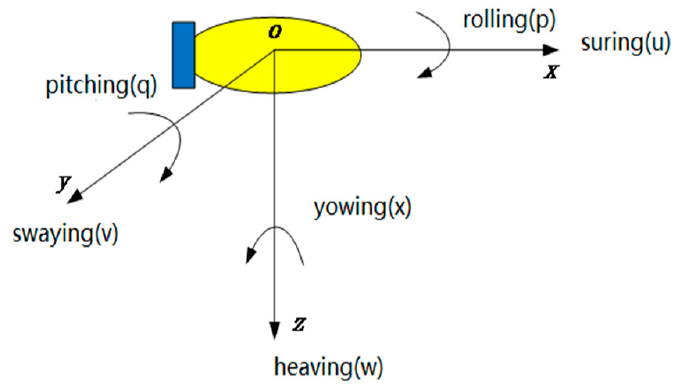
Figure 2. Ship body coordinate system.